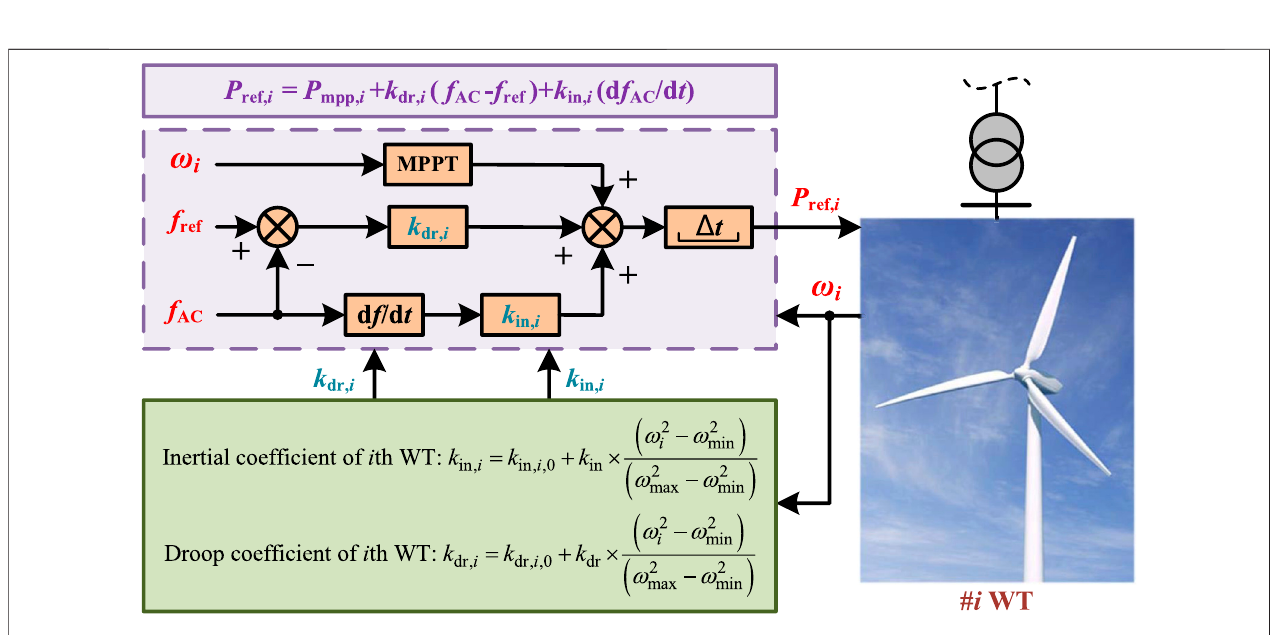
FIGURE 3 | Step start-up adaptive inertial droop control scheme for the i th WT.